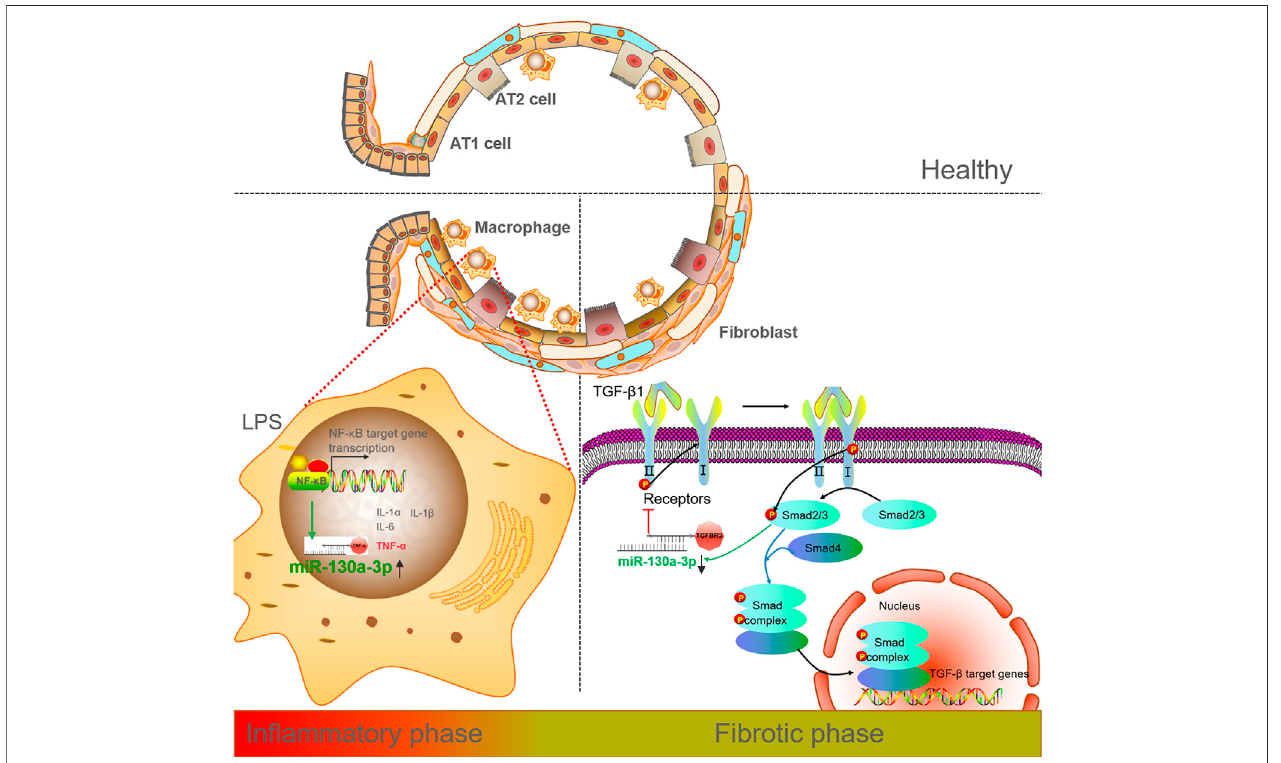
FIGURE 10 | Diagram of miR-130a-3p on PF in in fl ammatory and fi brotic phases. In the in fl ammatory phase, activation of the NF- κ B signaling pathway increases theexpression ofmiR-130a-3p,while overexpressionofmiR-130a-3p inhibits LPS-induced production ofTNF- α .Inthe fi broticphase, TGF- β 1decreasesmiR-130a-3p expression through the TGF- β 1/Smad pathway. Meanwhile, miR-130a-3p targets TGF- β RII and therefore inhibits the TGF- β 1/Smad pathway.